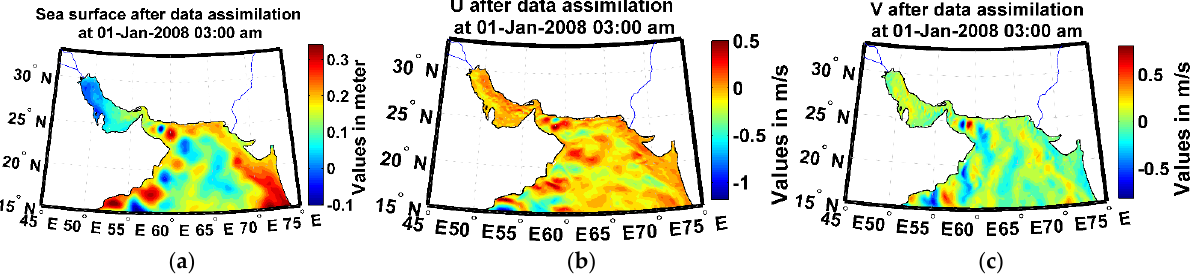
Figure 1. ( a ) Sea level height before data assimilation (calibration); ( b ) east–west component (u) of the SSC before data assimilation; ( c ) north–south component (v) of the SSC before data assimilation.